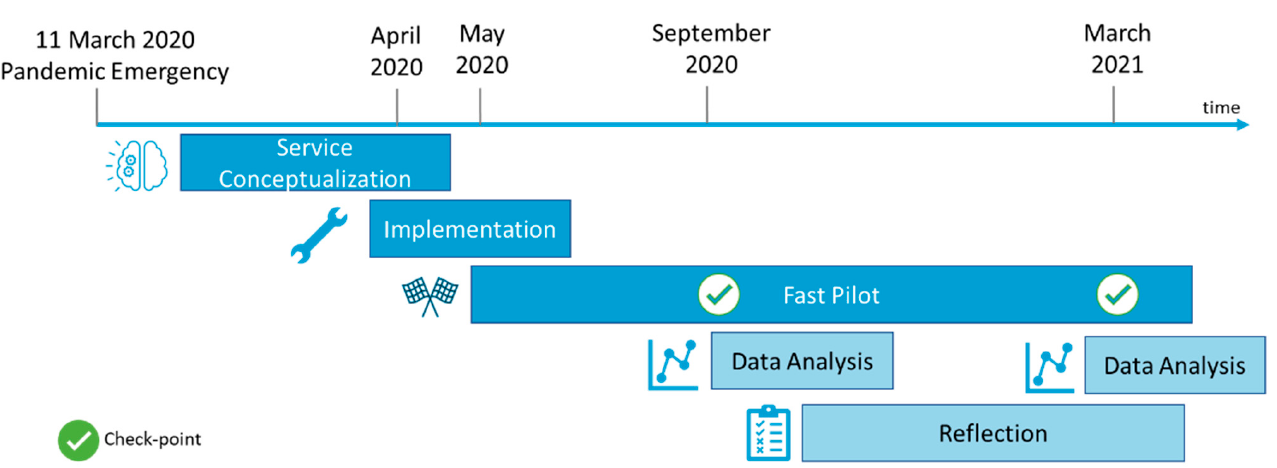
Figure 1. Phases of the proposed pilot study together with the timeline. Two checkpoints were fixed in September 2020 and in March 2021 to evaluate the proposed